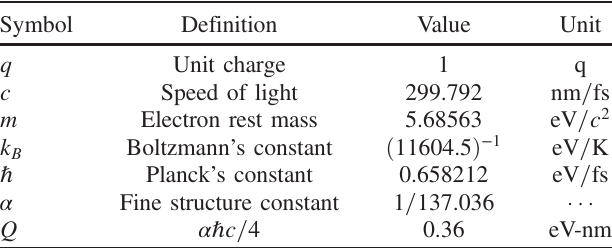
TABLE I. Fundamental constants. Units are characteristic of emission phenomena: elementary charge [ q ], length [nm], time [fs], energy [eV], and temperature [K] (for Kelvin).